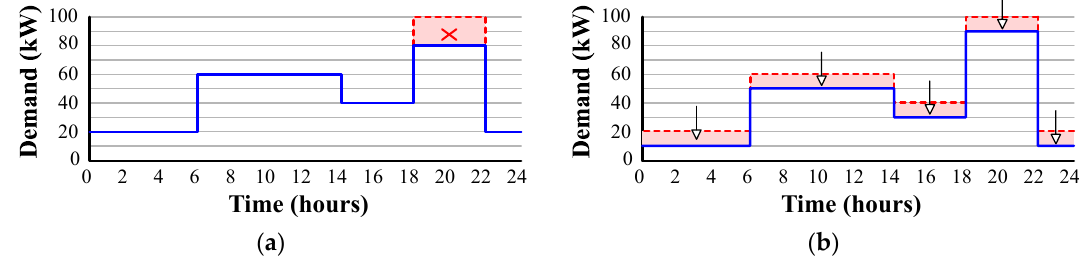
Figure 1. Load curve representing ( a ) peak shaving and ( b ) strategic conservation.